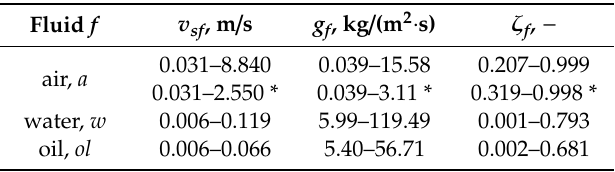
Table 3. Range of experimental